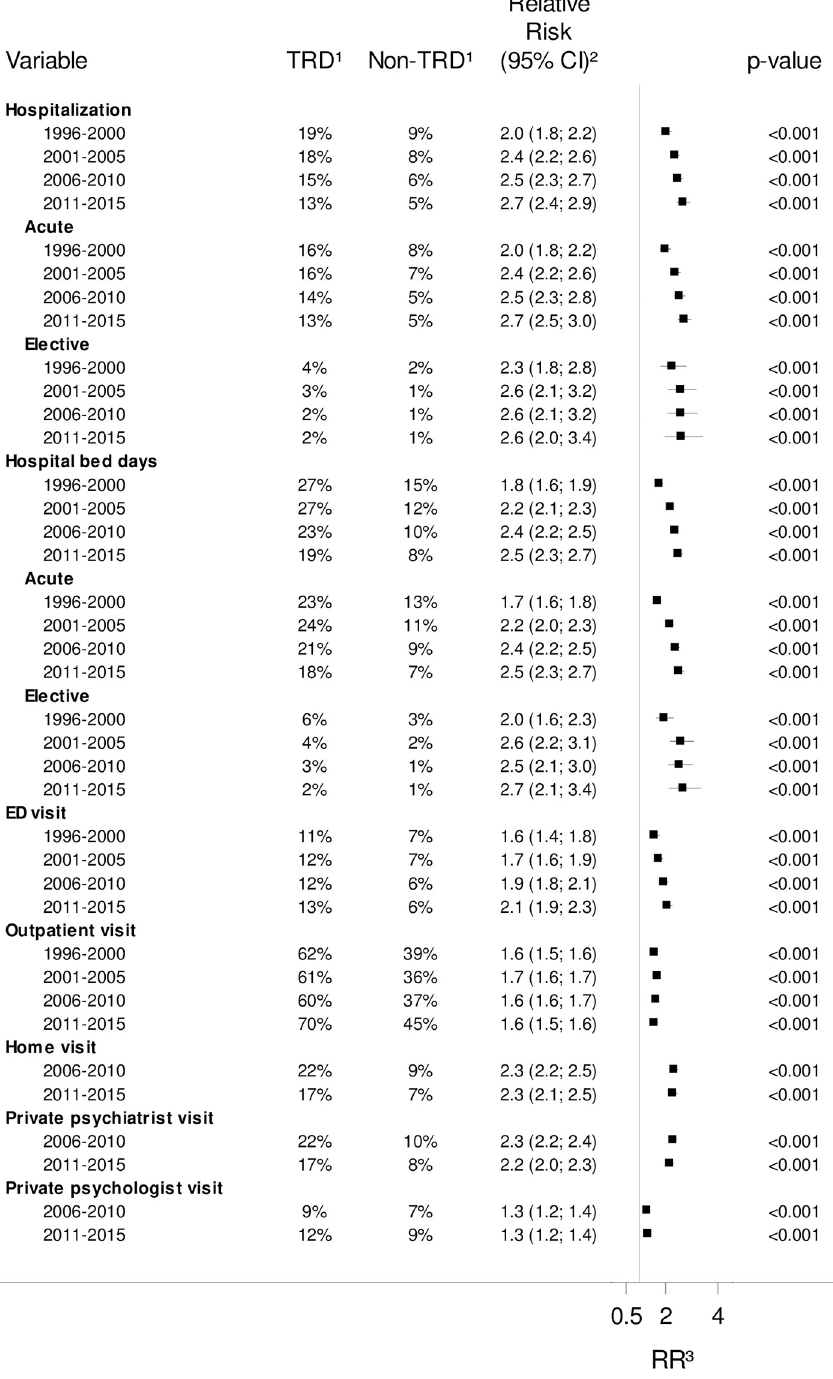
PLOS ONE | https://doi.org/10.1371/journal.pone.0275299 September 27, 2022 11 /